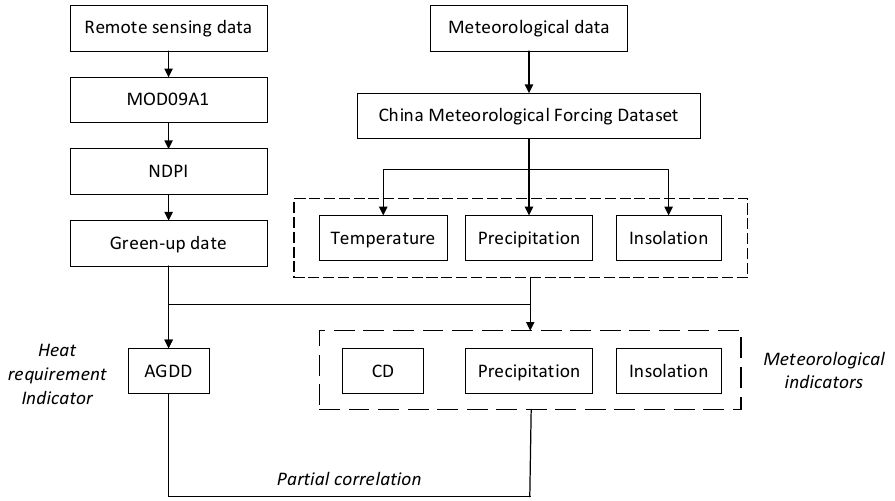
Figure 5. Flow chart of the key indicator computations and statistical analysis. NDPI: normalized difference phenology index. AGDD: accumulated growing degree-days. CD: chilling days.